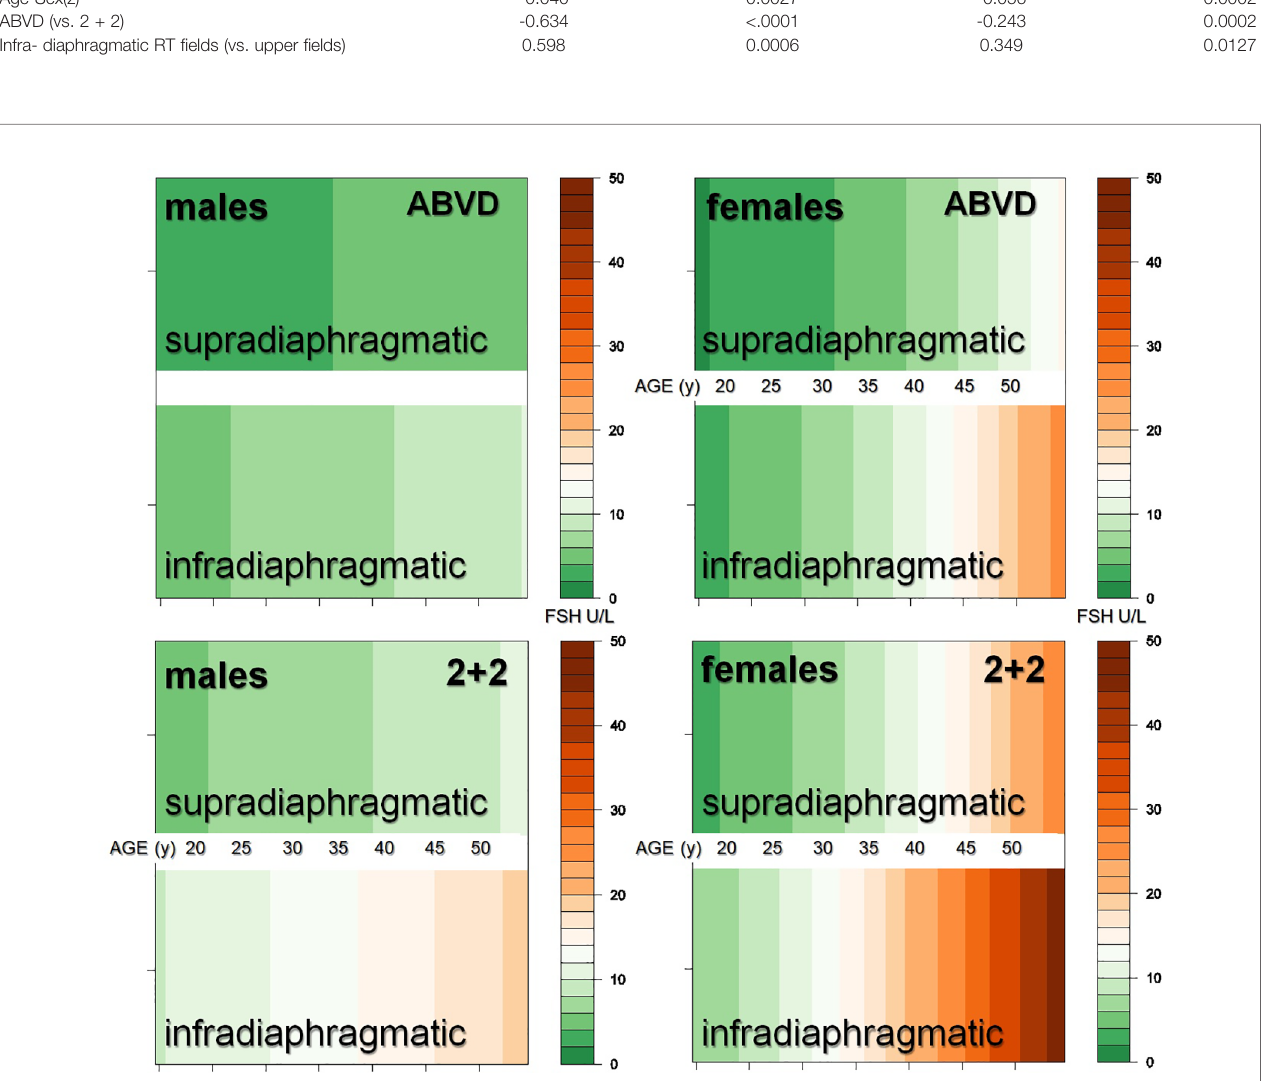
FIGURE 2 | FSH by RT-Field, chemotherapy, gender, and age as estimated in the multiple regression model of Table 3